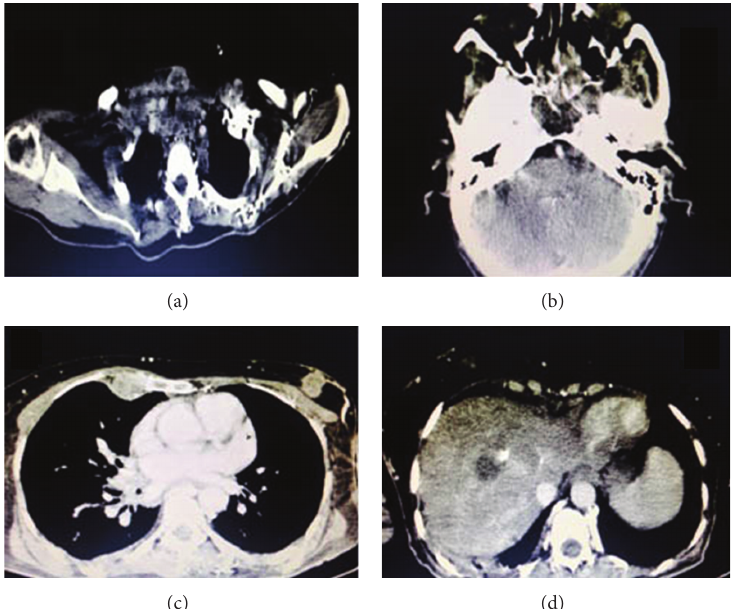
Figure 3: (a) Destruction of the right 4th rib along with erosion of the spinous processes of the thoracic vertebra and sclerotic lesions in the body of the vertebrae. (b) Destruction of the floor of middle cranial fossa, posterior ethmoidal air cells and sphenoid sinus. (c) Lesions in the mediastinum. (d) In liver multiple variable sized heterogeneous lesions containing foci of calcification were observed.